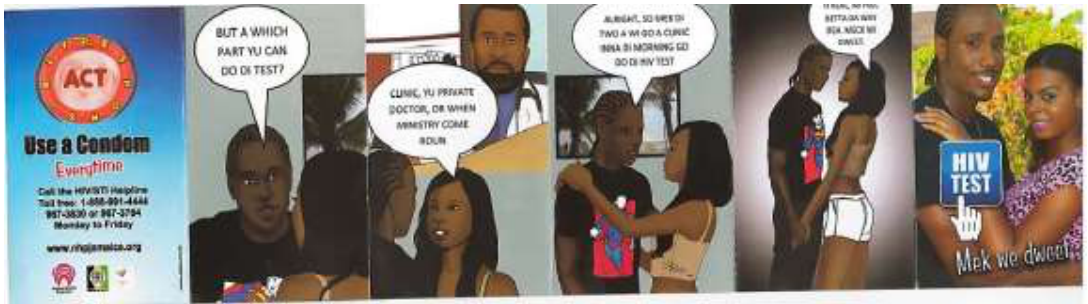
Figure 11. “ HIV Test: Mek we dweet ” brochure Targeted interventions among Key